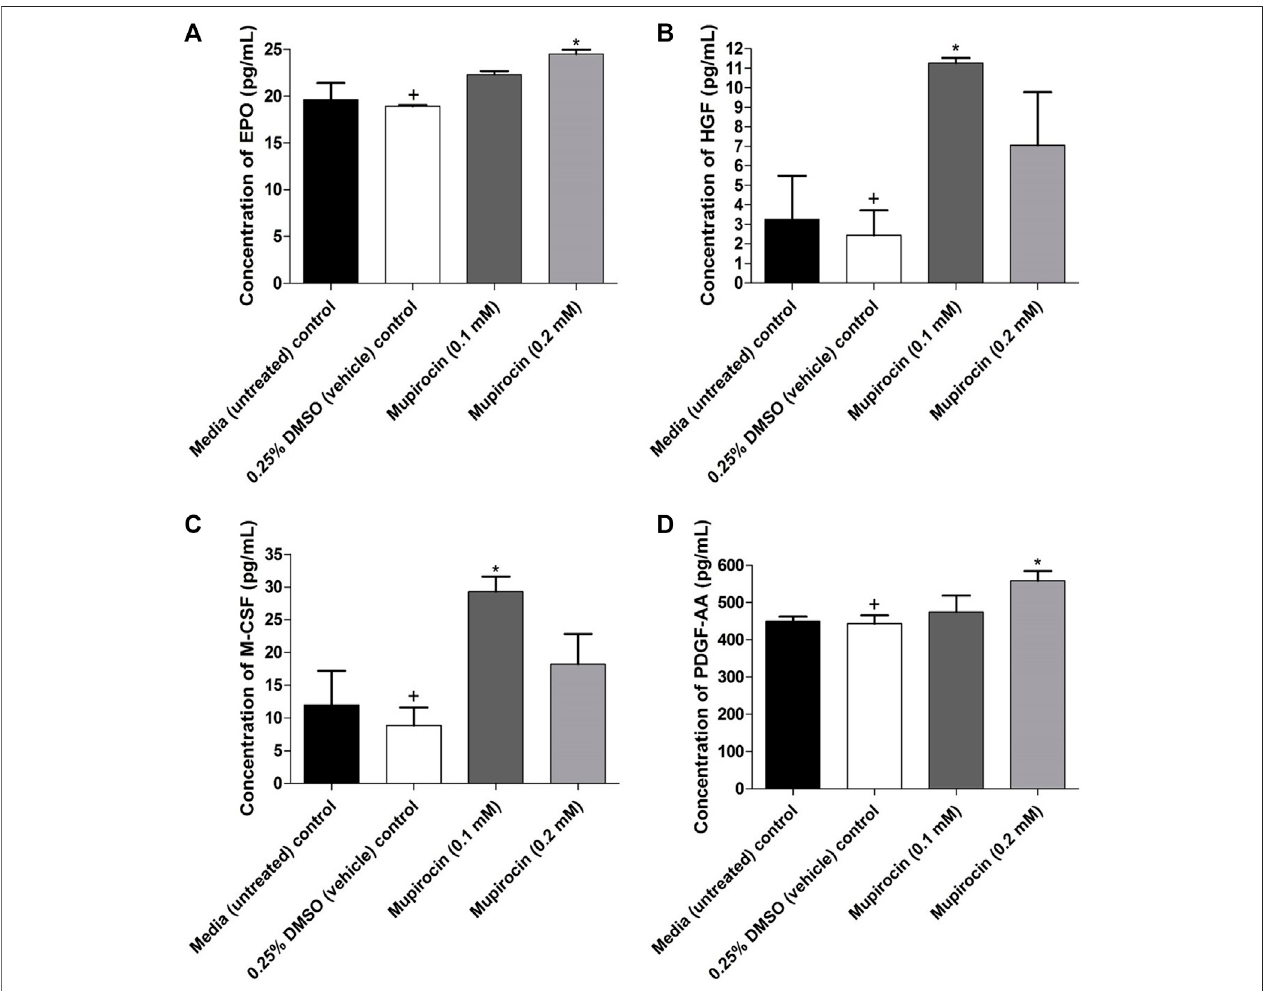
FIGURE 4 | Concentration (pg/ml) of (A) erythropoietin (EPO), (B) hepatocyte growth factor (HGF), (C) macrophage colony-stimulating factor (M-CSF) and (D) platelet derived growth factor AA (PDGF-AA) expressed by human keratinocytes (HaCat) treated with mupirocin (at 0.1 and 0.2 mM) after 18 h. Controls included cells grown in media (untreated) and cells treated with 0.25% DMSO (vehicle control). Data shown are mean ± SD ( n = 3). * p < 0.05 indicates statistical signi fi cance when compared to the 0.25% DMSO vehicle control (+). Statistical analysis was done using one-way ANOVA followed by Tukey ’ s multiple comparison